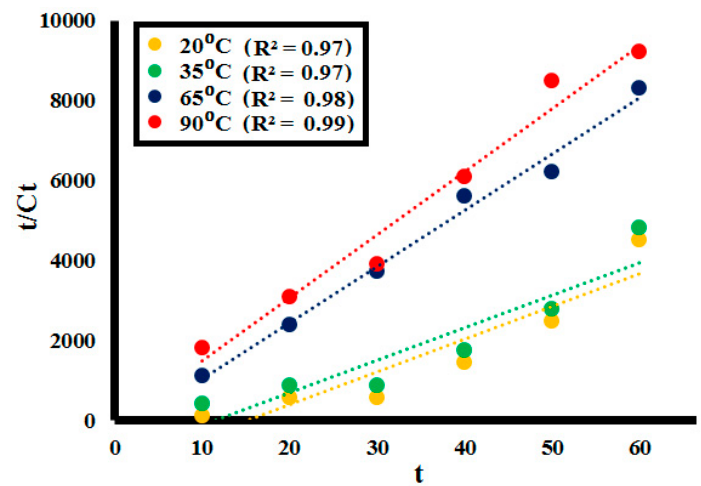
Figure 17. Pseudo-second order kinetics of the lignin depolymerization at different temperatures (20– 90 °C).